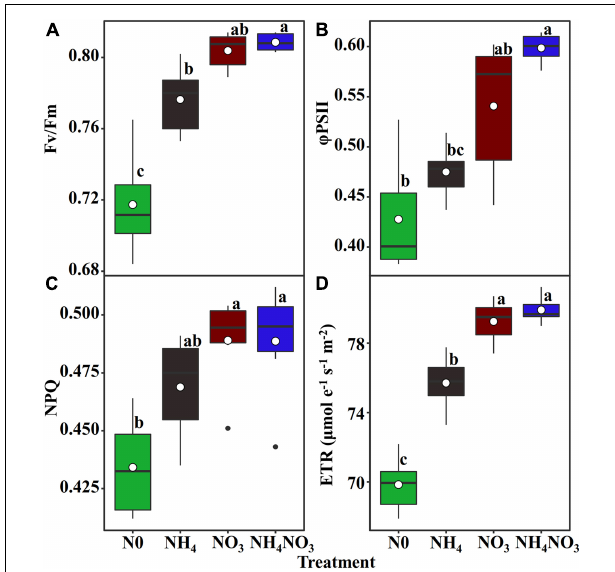
FIGURE 7 | Effect of N forms treatments on the maximum quantum yield of PSII (Fv/Fm) (A) , the effective quantum yield of PSII ( ϕ PSII) (B) , non-photochemical quenching coefficient (NPQ) (C) , and electron transport rate (ETR, µ mol e − 1 s − 1 m − 2 ) (D) in L. chinensis . White dot is “Mean”; black dot is “Outlier”; horizontal is “Median”; the top of vertical line is “Max” and the bottom of vertical line is “Min.” Different lower-case letters indicate significant differences under N0, NH 4 , NO 3 , and NH 4 NO 3 treatments ( p < 0.05) ( n =